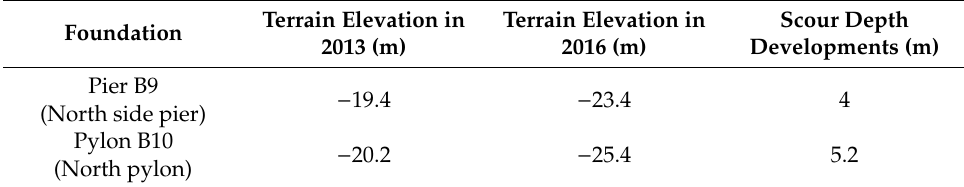
Figure 18. Underwater terrain map of the Hangzhou Bay Bridge. Table 10. Scour depth developments based on underwater terrain map.